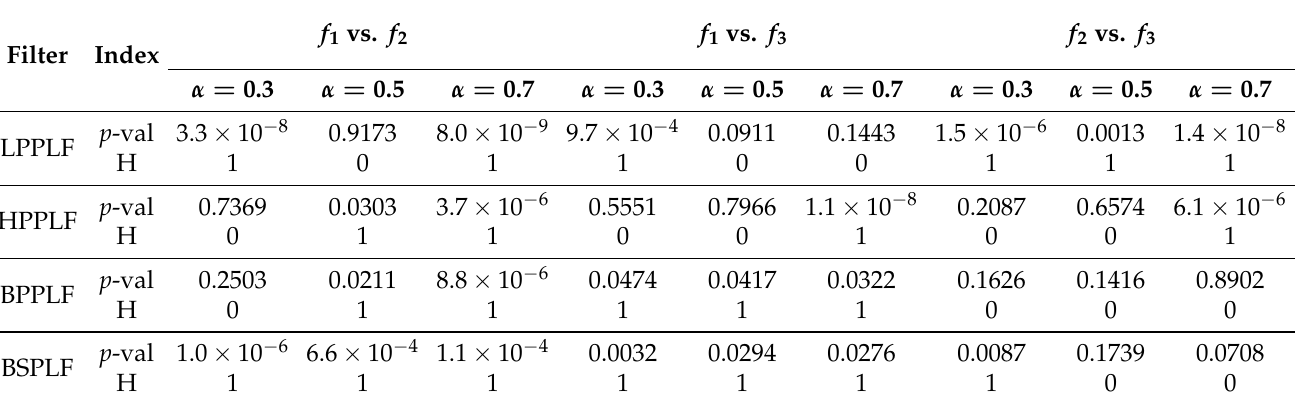
Table 3. Wilcoxon rank-sum test results for the designed PLFs.